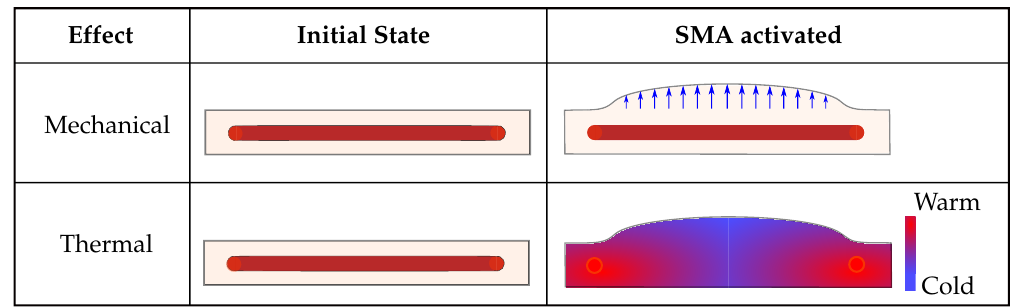
Figure 1. Representation of the effect with SMA activation